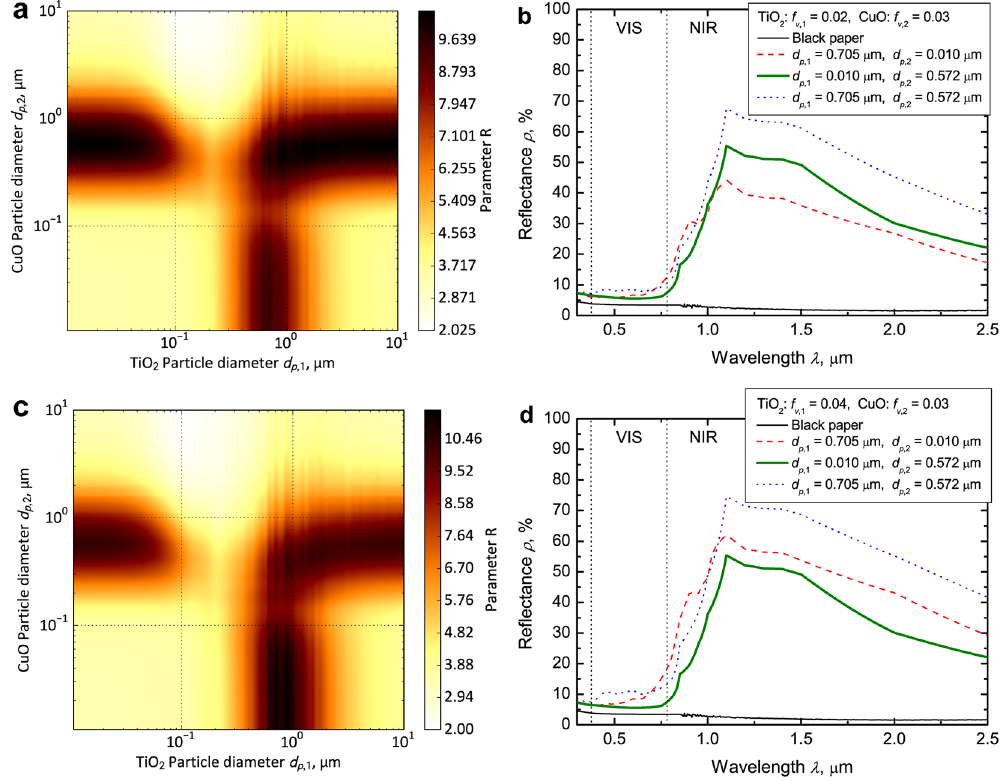
Figure 2. Effect of particle diameter on the optimization parameter when the VIS controlling particle is CuO and the NIR reflecting particle is TiO 2 . ( a ) Color map of R when f v ,1 is 0.02 and f v ,2 is 0.03. Optimization parameter R is maximum ( R = 10.38) when d p ,1 is 0.010 μ m and d p ,2 is 0.572 μ m. ( b ) Calculated spectral reflectance of C 3 when f v ,1 is 0.02 and f v ,2 is 0.03, d p ,1 is 0.705 μ m and d p ,2 is 0.010 μ m (red dashed curve; R = 9.11), d p ,1 is 0.010 μ m and d p ,2 is 0.572 μ m (green bold curve; R = 10.38), d p ,1 is 0.705 μ m and d p ,2 is 0.572 μ m (blue dotted curve; R = 9.20), and bare black paper (black curve). ( c ) Color map of R when f v ,1 is 0.04 and f v ,2 is 0.03. Optimization parameter R is maximum ( R = 10.59) when d p ,1 is 0.705 μ m and d p ,2 is 0.010 μ m. ( d ) Calculated spectral reflectance of C 3 when f v ,1 is 0.04 and f v ,2 is 0.03, d p ,1 is 0.705 μ m and d p ,2 is 0.010 μ m (red dashed curve; R = 10.59), d p ,1 is 0.010 μ m and d p ,2 is 0.572 μ m (green bold curve; R = 10.37), d p ,1 is 0.705 μ m and d p ,2 is 0.572 μ m (blue dotted curve, R = 8.34), and bare black paper (black